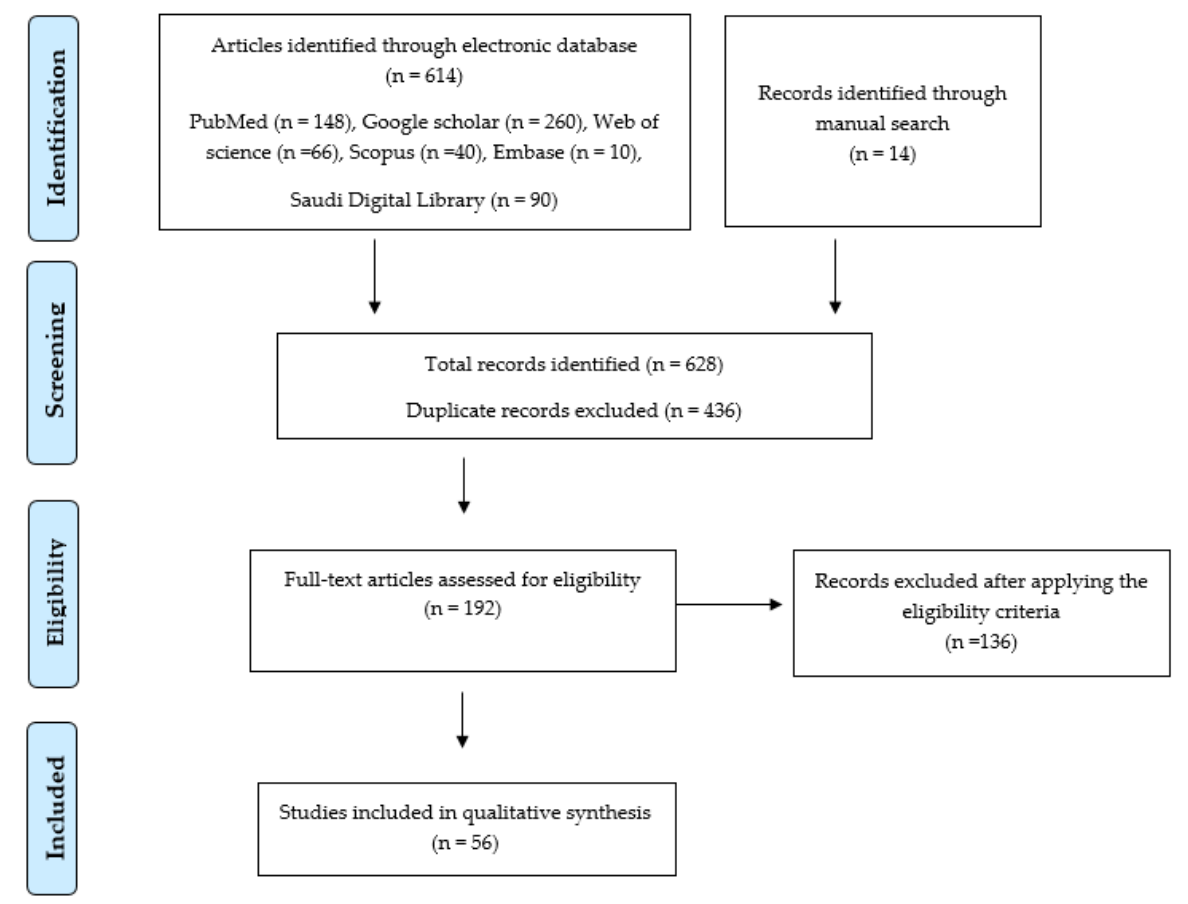
Figure 1. Flow chart for screening and selection of articles. Summary of AI models designed for different diagnostic tasks is presented in Table 2.